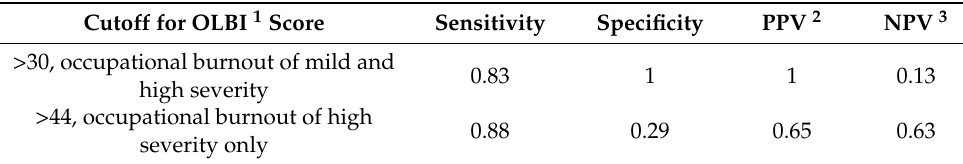
Table 2. Validity of the Tool.